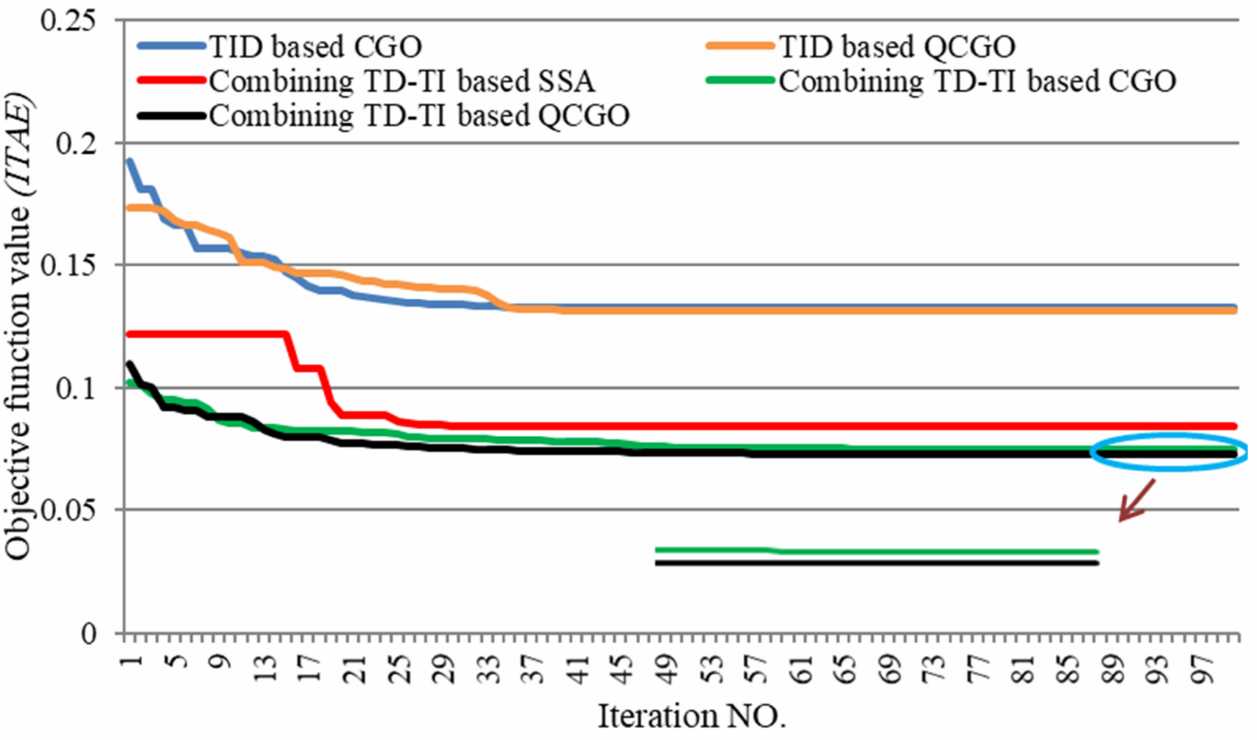
Figure 13. The convergence curve characteristics of QCGO, CGO, and salp swarm